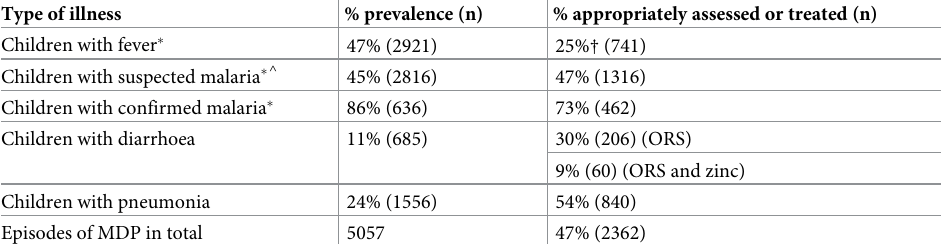
Table 1. Prevalence of children with fever, suspected malaria, diarrhoea or suspected pneumonia (MDP) and overall rates of appropriate testing (blood test for fever) and treatment. See S1C Table for additional definitions of appropriate treatment.